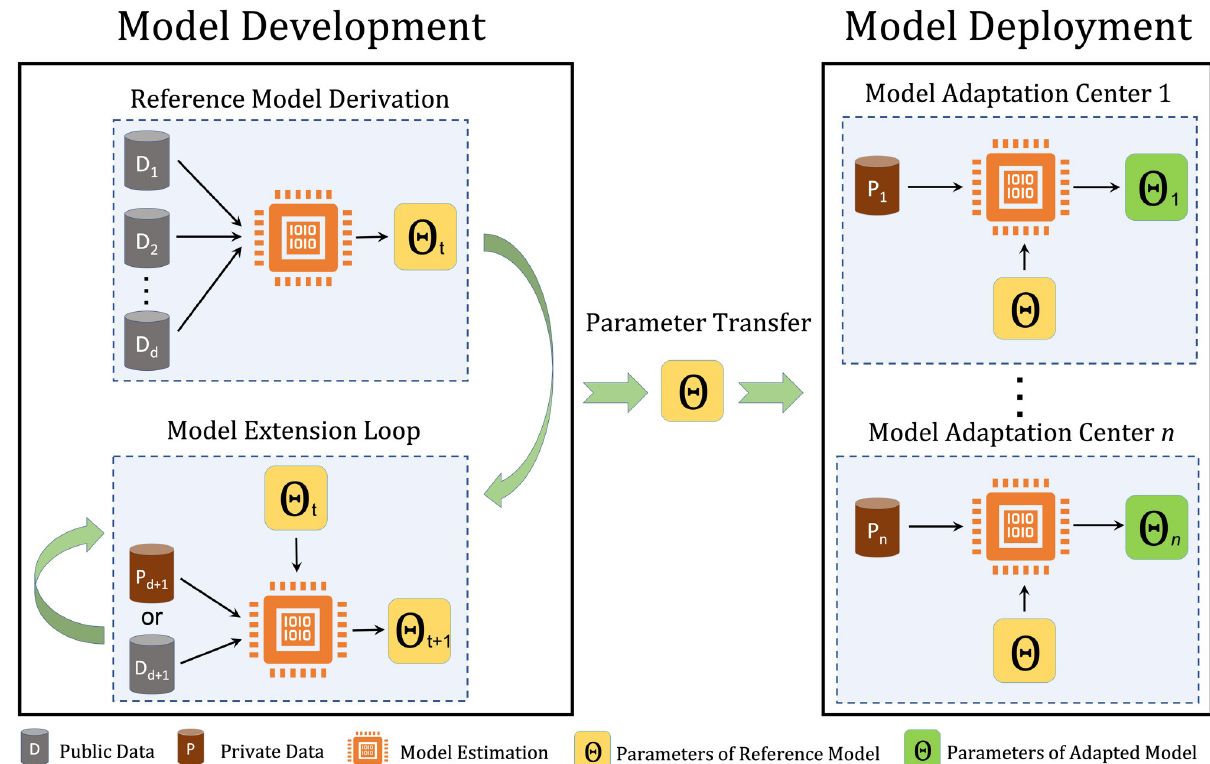
Fig 1. Model development and model deployment in the normative model life-cycle. In the model development phase, the parameters of the reference model are estimated on d datasets ( D 1 , D 2 , ... , D ). The model extension loop provides the possibility of model development on decentralized d data at time point t . In the model deployment phase, the parameters of the reference model are adapted to local data at hospitals or research centers.